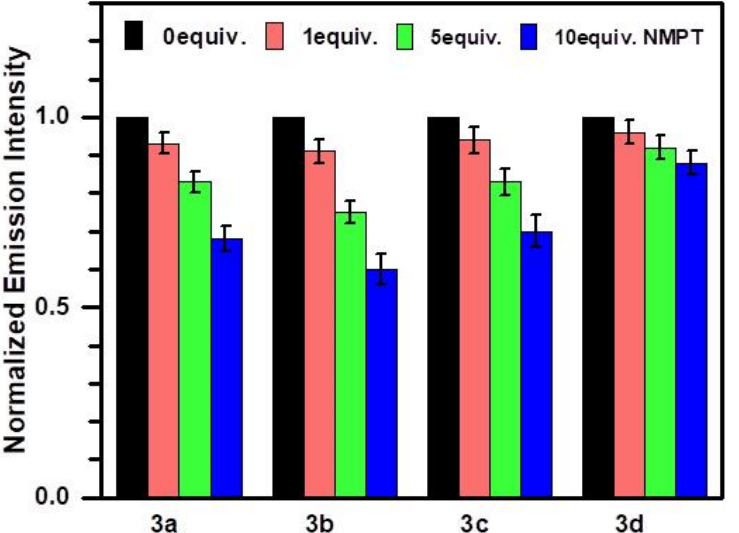
Figure 5. Fluorescence quenching in carbazole-appended calixarenes 3a – d (DCE, 10 µM) upon the addition of N-methylpyridinium triflate (NMPT, 2 ).